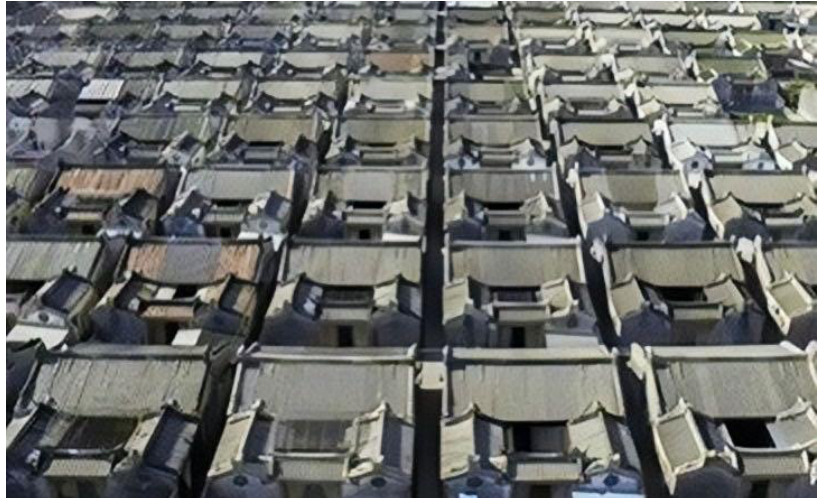
Figure 19. Four Points Gold buildings.